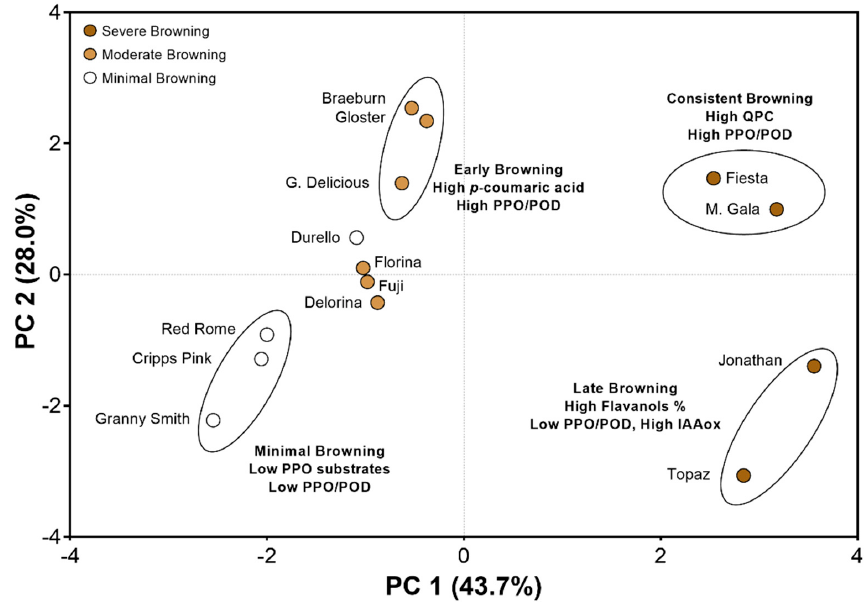
Figure 6. Principal component analysis (PCA) of apple cultivar characteristics such as color changes (i.e., browning), phenolic concentrations, and enzymatic activity. Large circles (scores) visualize the 14 cultivars, colored according to their browning severity (white = minimal, light brown = moderate, and dark brown = severe). PCA showcases that browning coloration and phenolic concentrations were a major contributor to variation amongst cultivars, with ~44% of the variation explained on PC1. An additional variation is explained along PC2 (28%) with enzymatic activity (PPO and POD) appearing to drive vertical separation amongst cultivars evaluated.